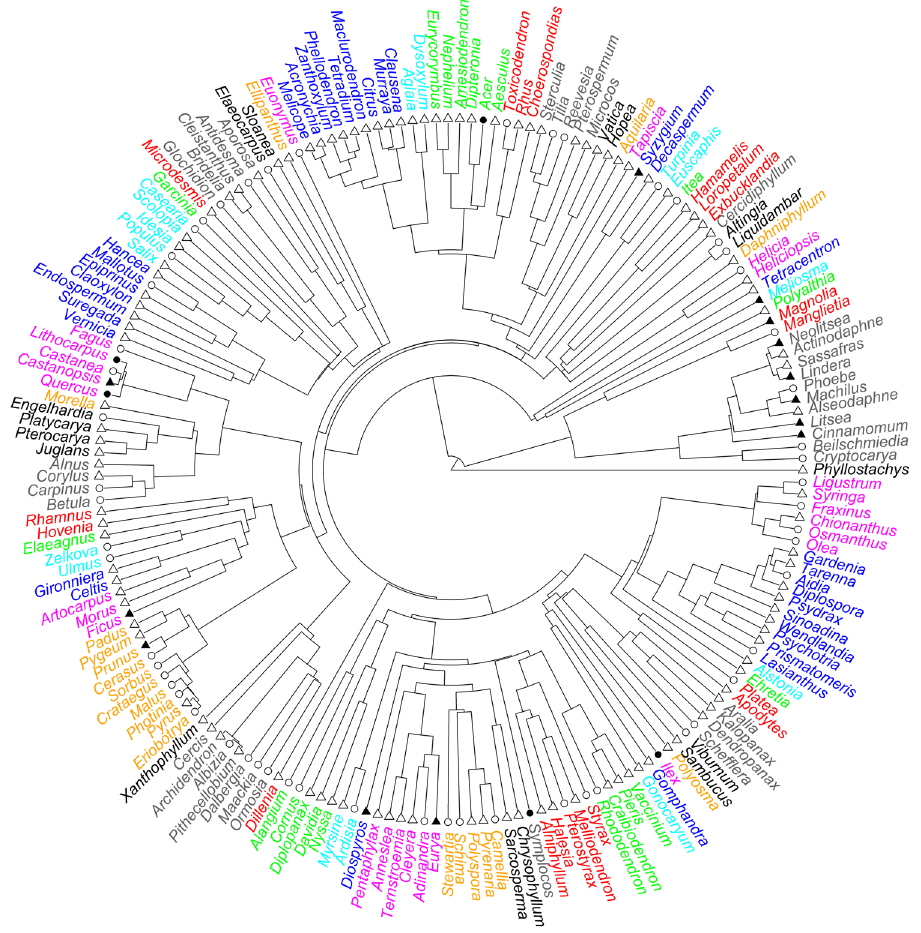
Figure 1. A phylogeny for 187 angiosperm tree genera in the studied forest plots (for illustrative purposes; analyses are based on a species-level phylogeny, see Methods). Genera within a cluster of the same color belong to the same family. The number of species in each genus was indicated by four different symbols: open triangles, 1 species; open circles, 2–5 species; filled triangles, 6–10 species; filled circles, > 10